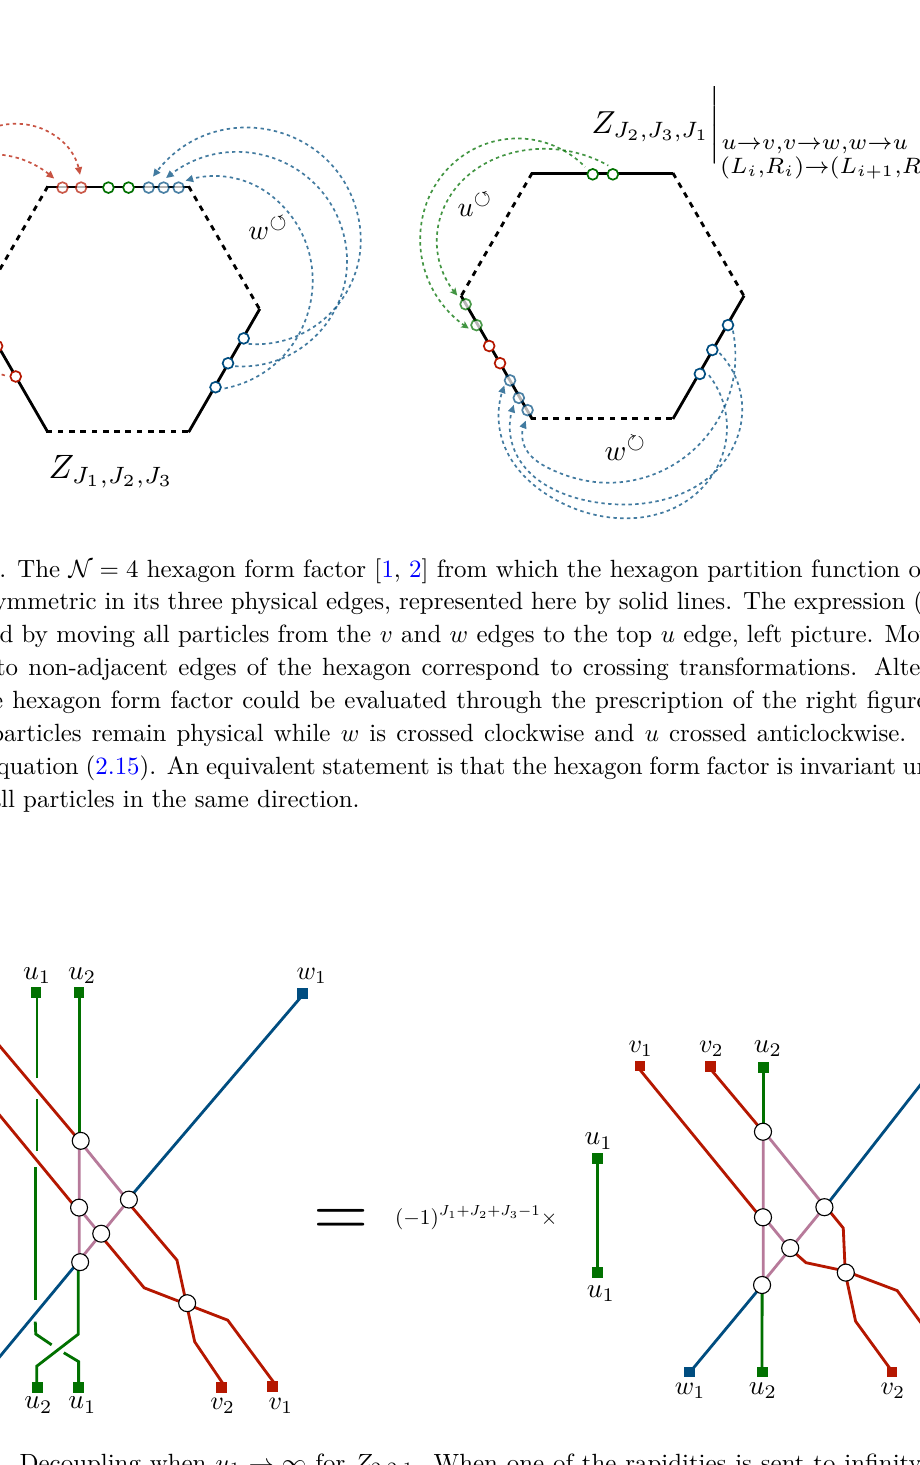
are of the fermion-fermion type, 1